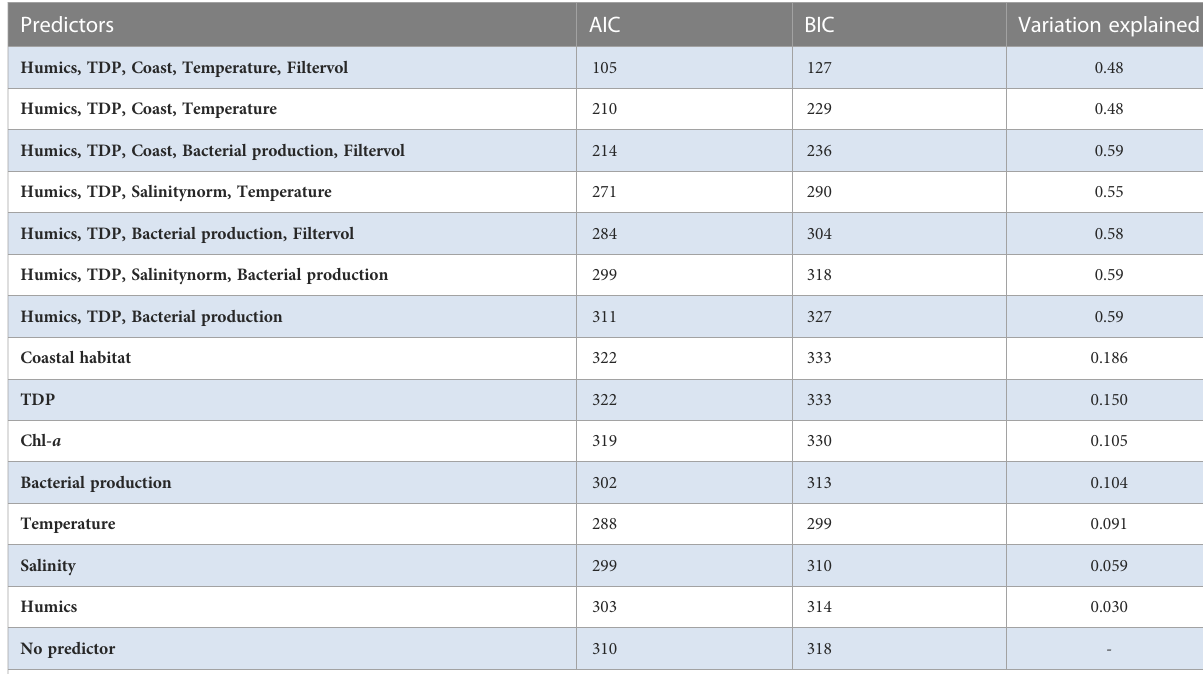
TABLE 1 Variation explained in the Amplicon Sequence Variant (ASV) communities for each environmental variable (according to the ratio of traces). Predictors AIC BIC Variation explained 105 127